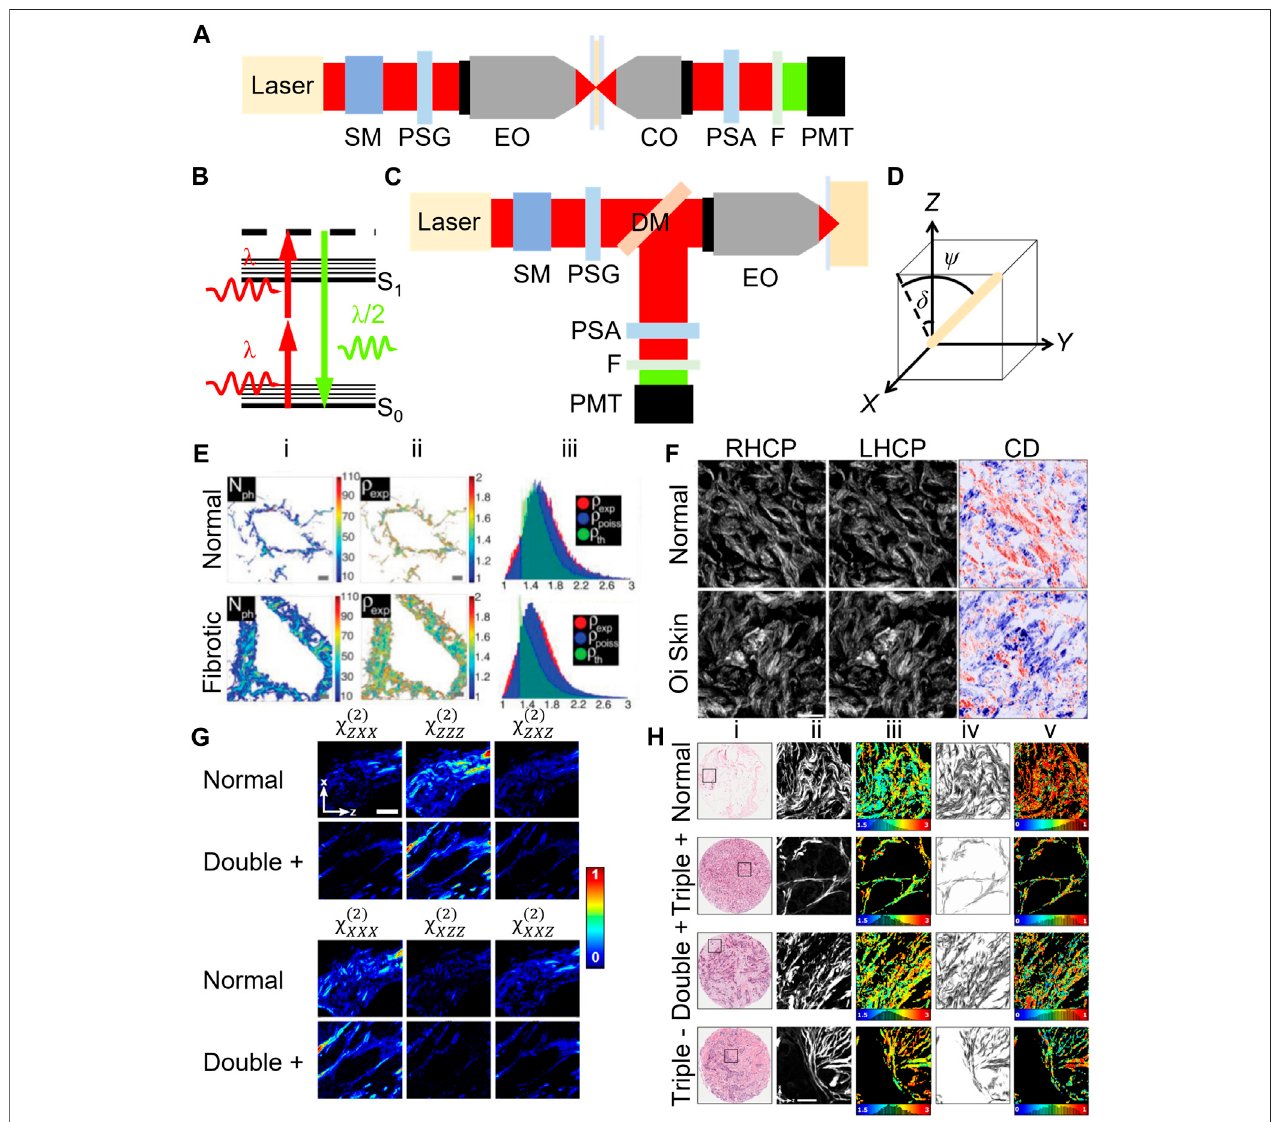
FIGURE 1 | Typical microscope schematics for forward- (A) and epi-detection (C) con fi gurations for polarization-sensitive second harmonic generation (SHG) microscopy. The energy state diagram of SHG (B) along with the coordinate system, where Z-X is the image plane and the laser propagates along Y, for an arbitrarily oriented fi ber (D) is shown. Abbreviations: SM-scanning mirrors, PSG-polarization state generator, EO-excitation microscope objective, CO-collection microscope objective, PSA-polarization state analyzer, F- fi lter, PMT-photomultiplier tube detector and DM-dichroic mirror. Example images obtained using PI-SHG (E) , CD- SHG (F) ,DSMP-SHG (G) andPIPO-SHG (H) .SHG intensity(E-i), fi tted ρ (E-ii)and fi tted ρ distributionwidth(E-iii)areshownfornormaland fi broticliver[14].SHGimages (F) ofnormalskinandosteogenesisimperfecta(O-i)skintissuesusingright-handedcircularlypolarizedlight(RHCP),left-handedcircularlypolarizedlight(LHCP)andCD- SHG (CD) where red and blue show positive and negative values, respectively [43]. Laboratory-frame χ (2) values (G) of normal and double + breast tissue using DSMP- SHG [44].Bright fi eld(H-i),SHG (H-ii), ρ (H-iii), δ orientation(H-iv)andDOLP(H-v)imagesofnormal,triple+,double+,++-,andtriple – breasttissue[44].ImagesE-Hwere adapted with permission from [14, 43, 44] © The Optical